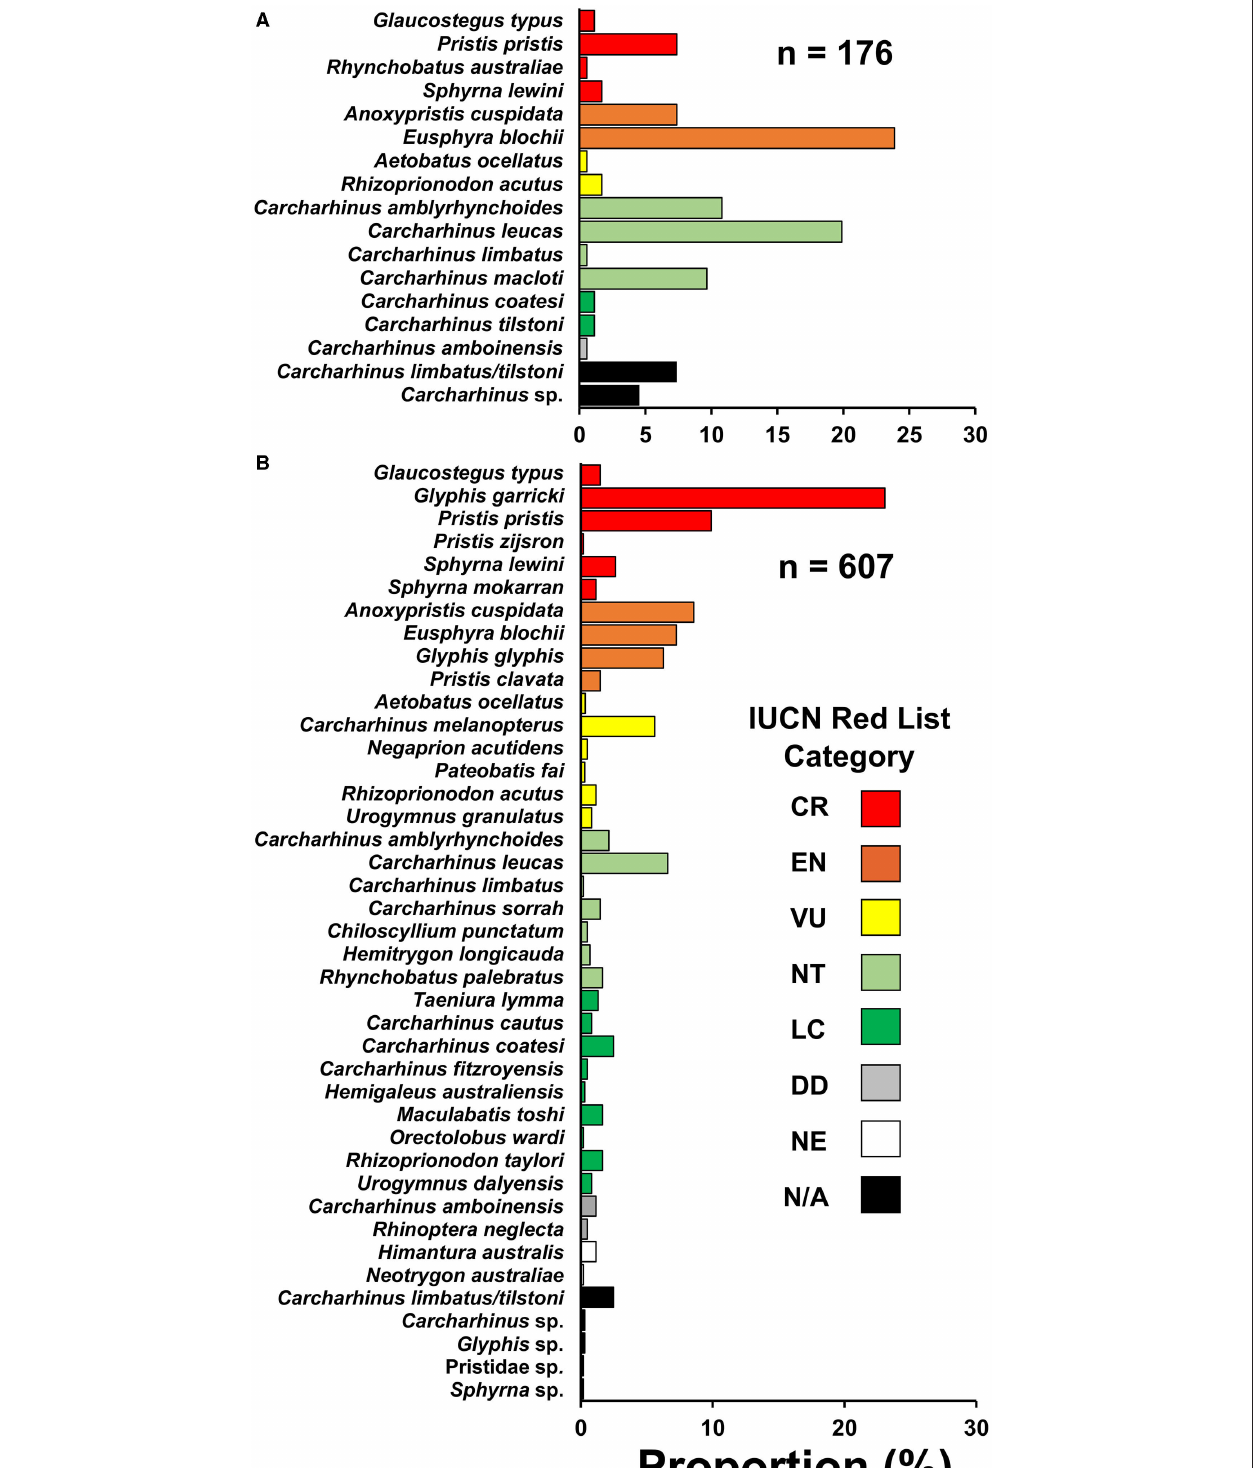
Frontiers in Conservation Science |